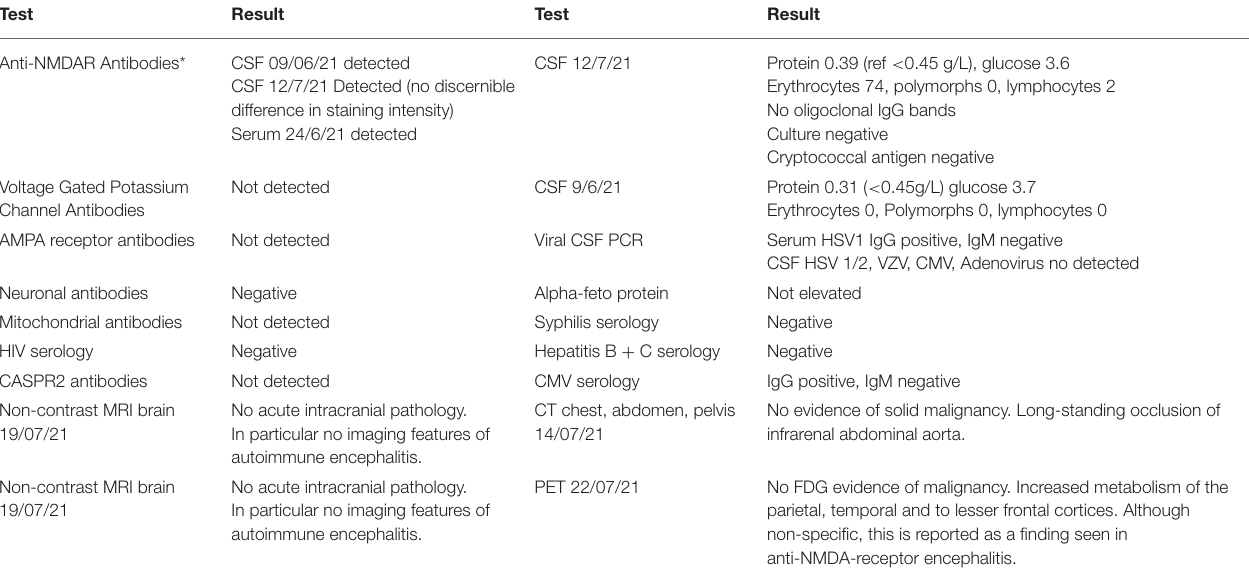
TABLE 2 | Results table. Test Result Test Anti-NMDAR